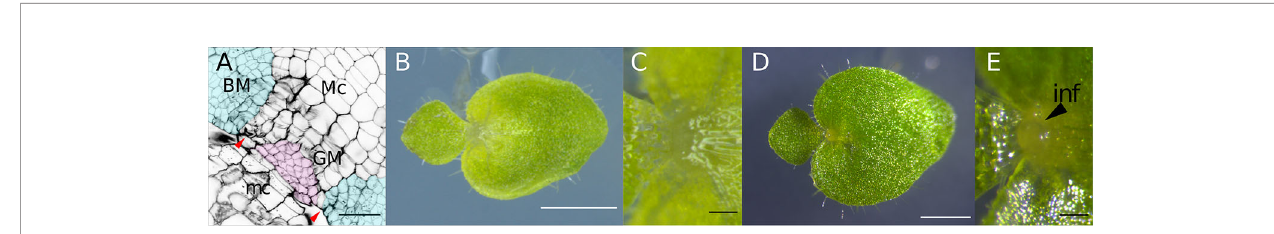
FIGURE 1 | The meristem position in anisocotyledonous-stage M . glabra . (A) Paradermal view confocal micrograph of the tissue structure in an anisocotyledonous individual stained with calco fl uor white. The upper right leaf is the macrocotyledon, and the lower left leaf is the microcotyledon. The positions of the GM and the BM are colored pink and pale blue, respectively with an image processing software. The red arrowheads show the position where changes in contour in the macrocotyledon were observed. (B) An anisocotyledonous-stage (17 DAS) individual in the vegetative phase grown under continuous light. (C) The basal part of the macrocotyledon of the individual in (B) . (D) An anisocotyledonous-stage (32 DAS) individual in the reproductive phase grown under short-day conditions. (E) The basal part of the macrocotyledon of the individual in (D) . Black arrowhead, bulging in fl orescence produced from the basal part of the macrocotyledon. BM , basal meristem; GM , groove meristem; inf , in fl orescence; mc , microcotyledon; Mc , macrocotyledon. Bar = 50 µm in (A) , 1 mm in (B, D) , 100 µm in (C, E)